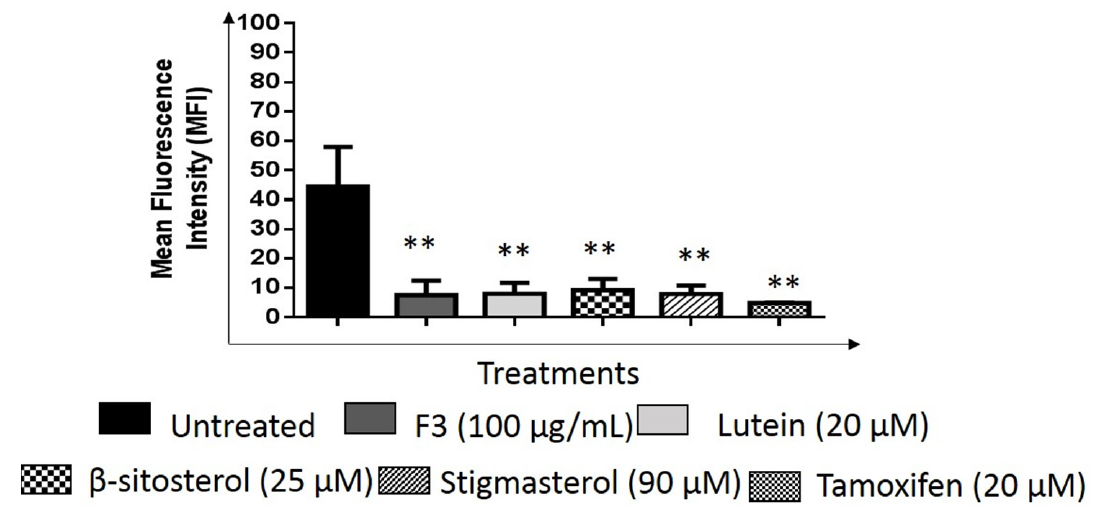
Figure 12. Fibronectin protein expression. MDA-MB-231 cells treated with the indicated concentra- tions F3, lutein, β -sitosterol, and stigmasterol for 24 h was compared to untreated cells. Tamoxifen was used as a positive control. Data are presented as the mean ± SD ( n = 3). ** p < 0.01 .